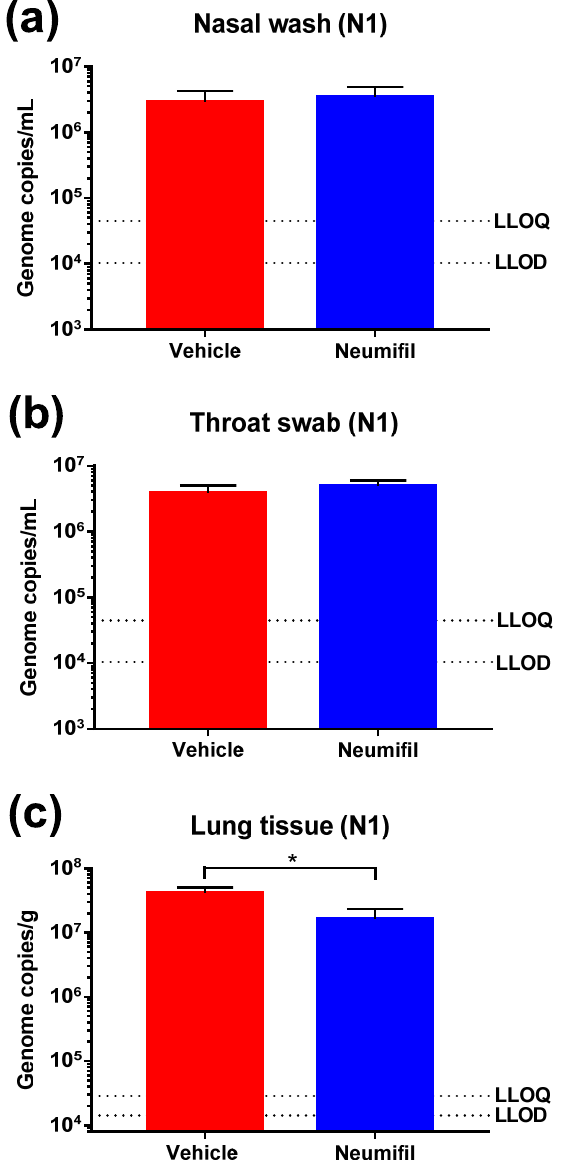
Figure 3. Viral RNA levels in ( a ) nasal washes, ( b ) throat swabs, and ( c ) lung tissue samples taken from Neumifil- and mock-treated hamsters 7 days after SARS-CoV-2 challenge. Samples were tested in an N1-based PCR assay. LLOQ, lower limit of quantification; LLOD, lower limit of detection. *, p < 0.05 (Mann–Whitney test). n = 6 hamsters per group.